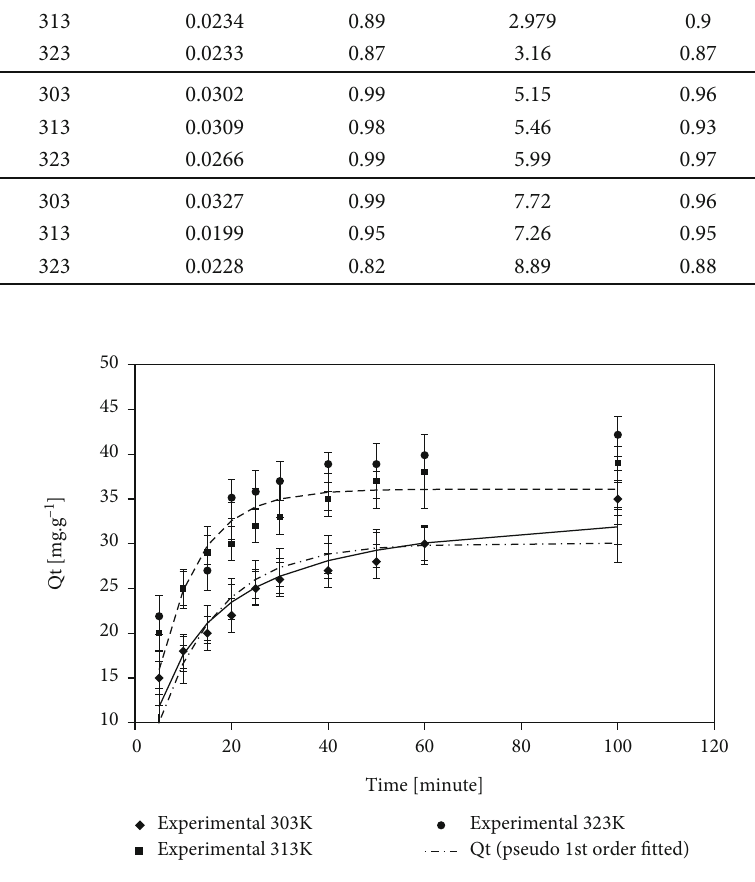
Figure 14: 50ppm CV concentration on PSS kinetic model fi t at temperatures 303K, 313 K, and 323